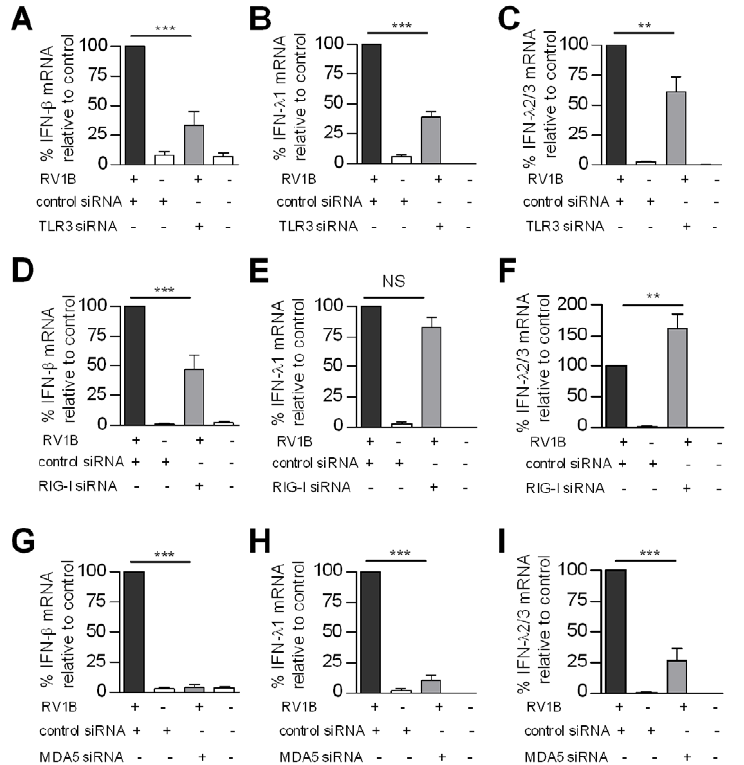
Figure 4. Role of TLR3, RIG-I and MDA5 in RV1B induced IFN- b , and IFN- l gene expression in HBECs. HBECs were transfected with control siRNA or siRNA specific for TLR3 (A–C), RIG-I (D–F), MDA5 (G–I), and infected with RV1B. IFN- b (A,D,G), IFN- l 1(B,E,H) and IFN- l 2/3 (C,F,I) mRNA were measured 24 h post infection ** p , 0.01, *** p , 0.001 versus control siRNA, NS=not significant. mRNA data was generated from 6 independent experiments utilizing 3 independent HBEC donors, 2 experiments per